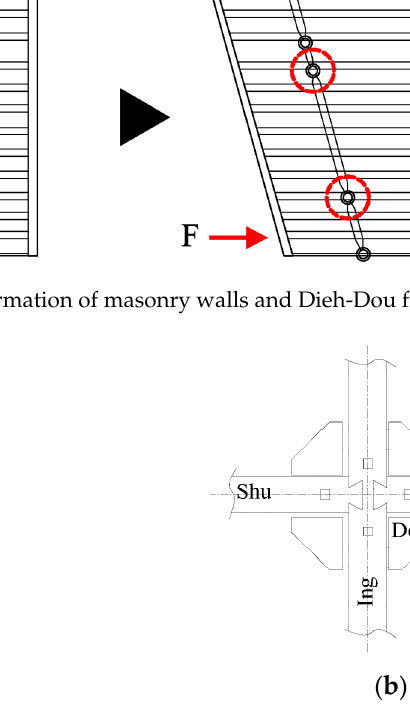
Figure 5. Relative movement of the components in Zuo-Dou joints: ( a ) horizontal rotation; ( b ) in-plane shear.